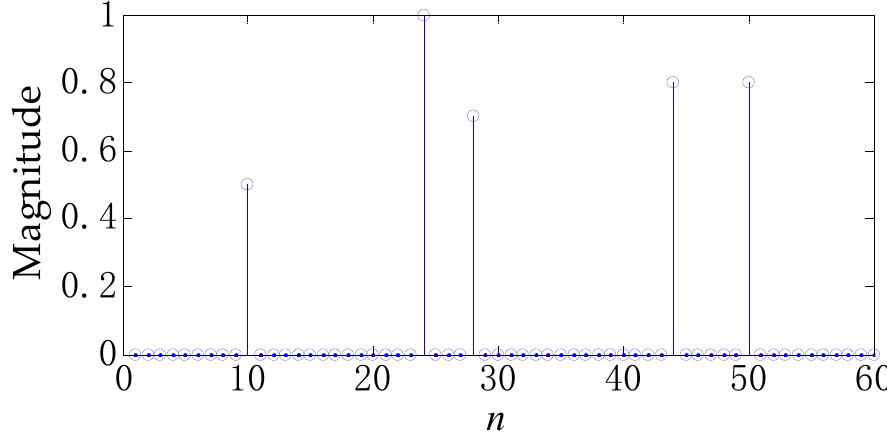
Figure 5. The actual target impulse response.